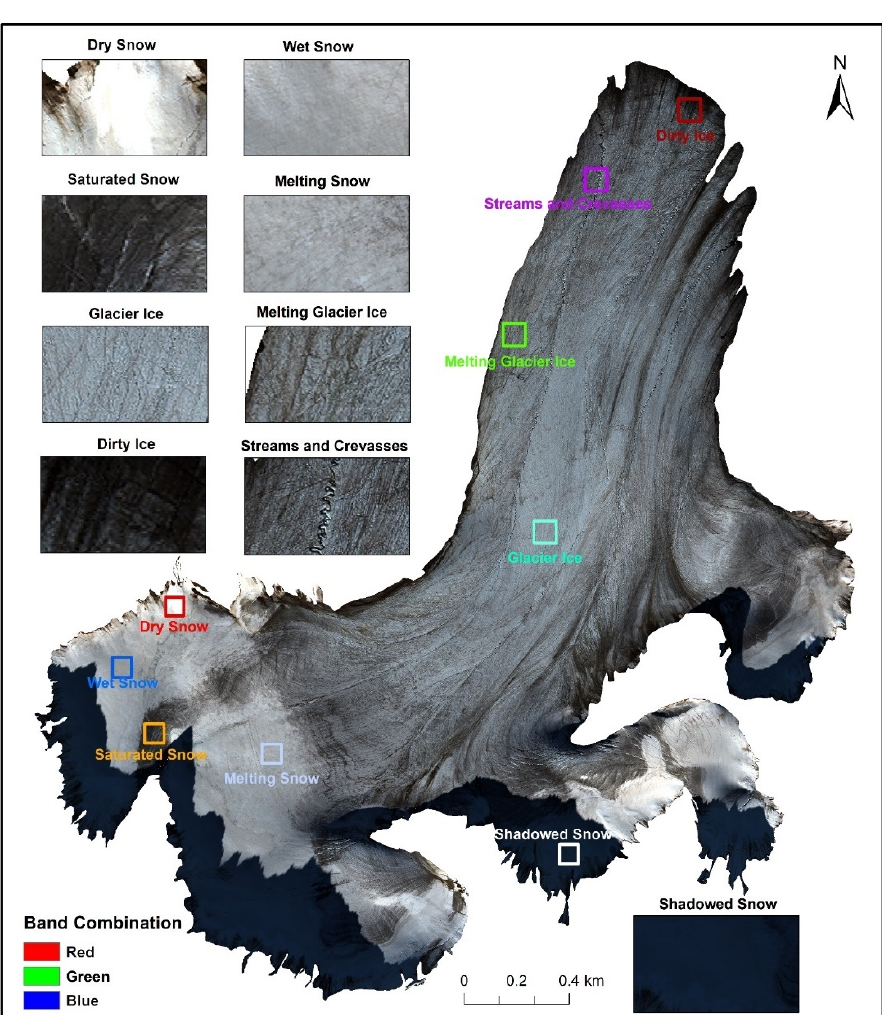
Figure 3. Visual characteristics of identifiable glacier facies displayed on the ML glacier. Boxes on the glacier highlight location of target facies. Zoomed and labelled insets display the visual characteristics of each facies.